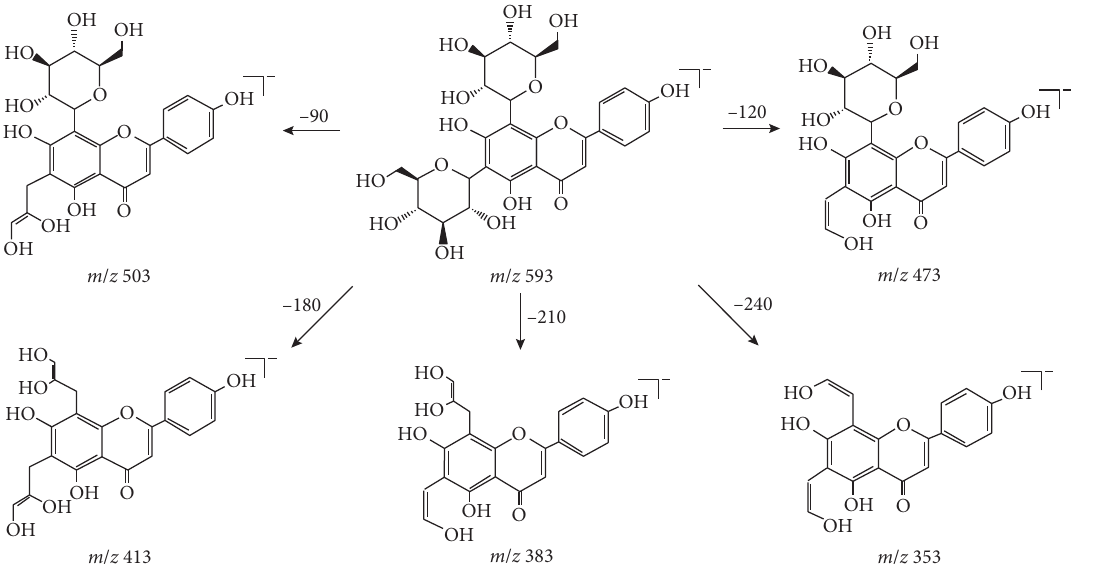
Figure 3: The possible dissociation pathway of the component of peak